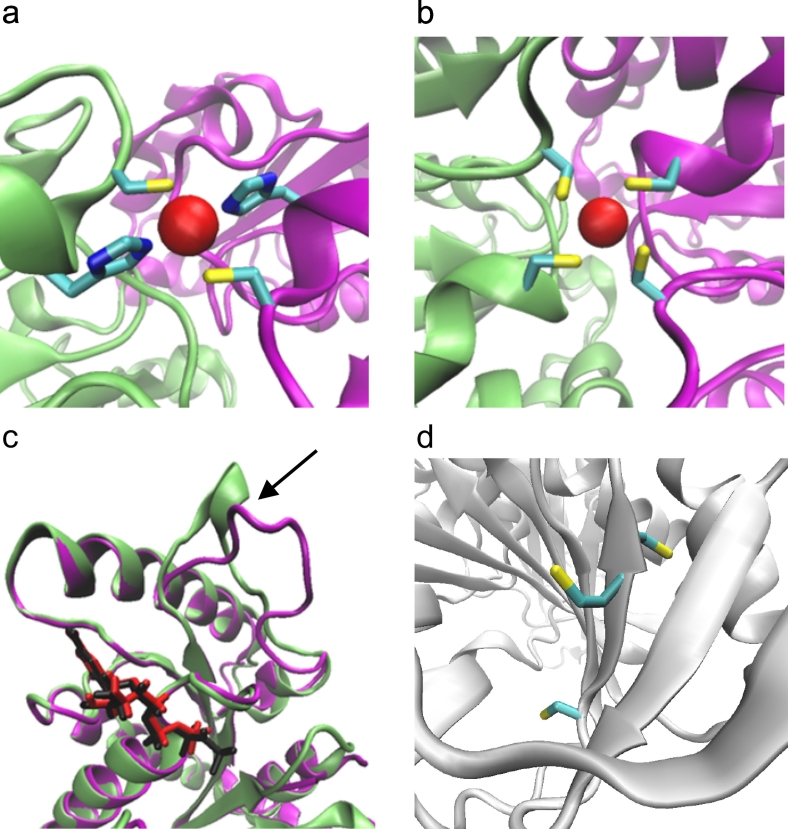
Allosteric relationship between nucleotide and substrate binding in G3E GTPases.a–b Square-planar Ni(II) coordination sites at dimeric interfaces in (a) Klebsiella pneumoniae UreG (in complex with GMPPNP; PDB 5XKT [220]) and (b) Helicobacter pylori HypB (in complex with GDP; PDB 4LPS [222]); the two protomers of each homodimer are coloured green and magenta, respectively. c) Structure of Methylorubrum extorquens MeaB in complex with GMPPNP (green; PDB 4JYB [226]) or GDP (magenta; PDB 4LC1 [226]); bound nucleotides are shown in black and red, respectively. Arrow points to the ‘Switch III’ loop, which changes conformation upon nucleotide hydrolysis and is crucial for chaperone function [226]. d) The CXCC putative metal-binding motif in Escherichia coli YjiA (of the COG0523 family; PDB 1NIJ [227]), crystallised in the absence of nucleotides.